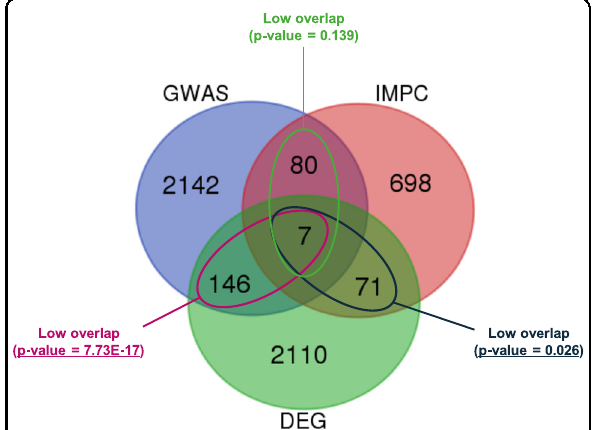
Fig. 3 Tissue-speci fi c DEGs between the lean healthy group and obese/diabetic group Fig. 4 Genes that were identi fi ed from each data type and their